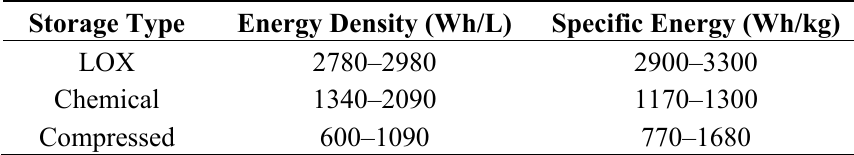
Table 4. Oxygen storage system energy content (based on